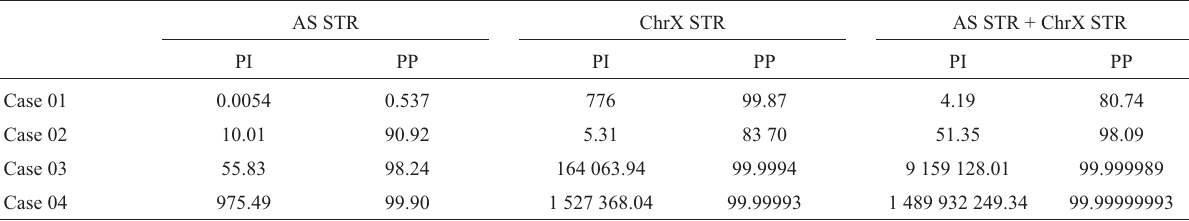
Table 1 - Combined Paternity Index (PI) and Probability of Paternity (PP) for autosomal STRs (AS STRs), X chromosome STRs (ChrX STRs) and a combination of AS/ChrX STRs.